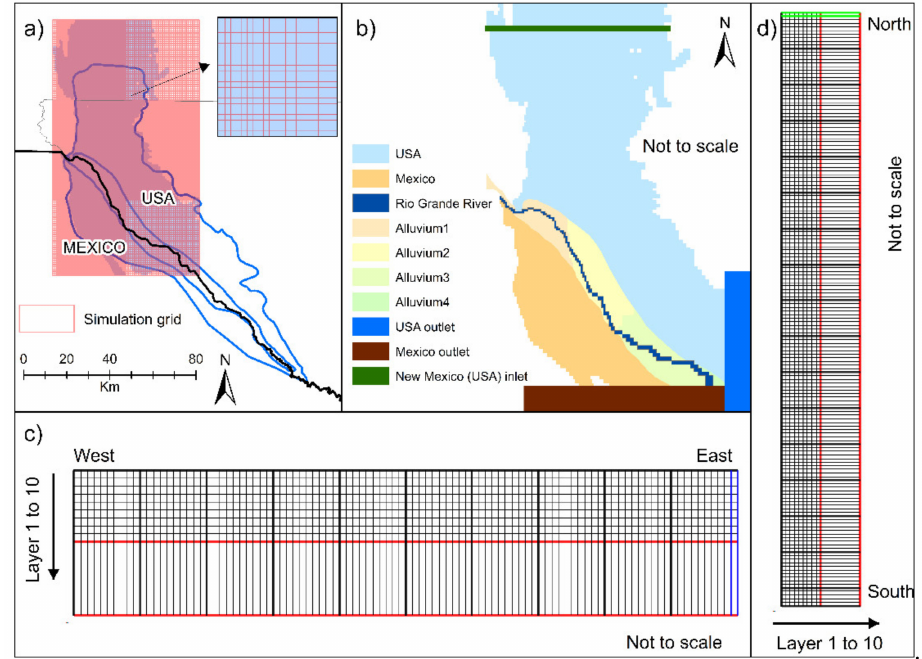
Figure 3. ( a ) Computational grid consisting of 165 rows and 100 columns. Inset shows a close location highlighting different grid sizes varying from 500 to 1170 m; ( b ) the location of inflow and outflow boundaries and other features; ( c ) West to East cross-section showing ten vertical layers; and ( d ) North to South cross-section showing ten vertical layers. Four alluvium areas were defined based on hydraulic characteristics along the river channel. The red color in ( c , d ) shows the computation grid’s bottommost layer has a different vertical thickness compared to the other nine